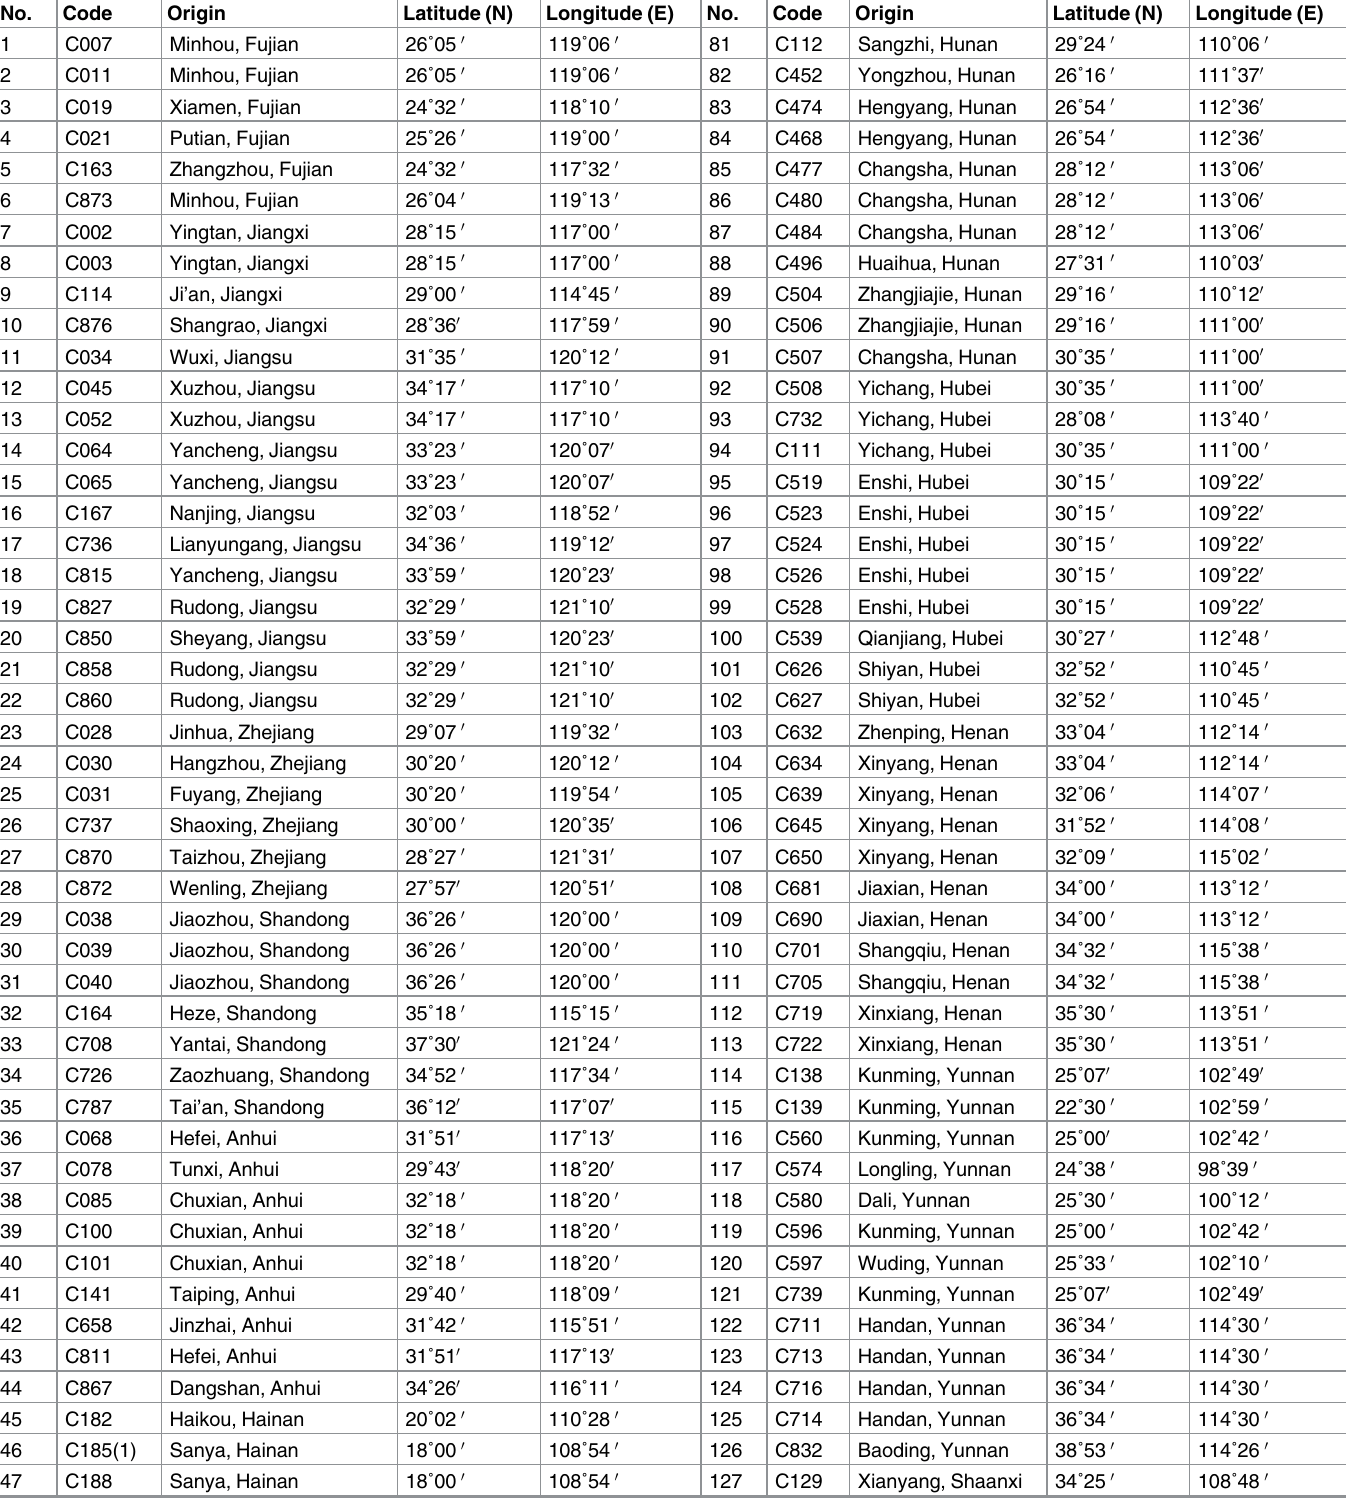
Table 1. Bermudagrass accessions analyzed in this study.